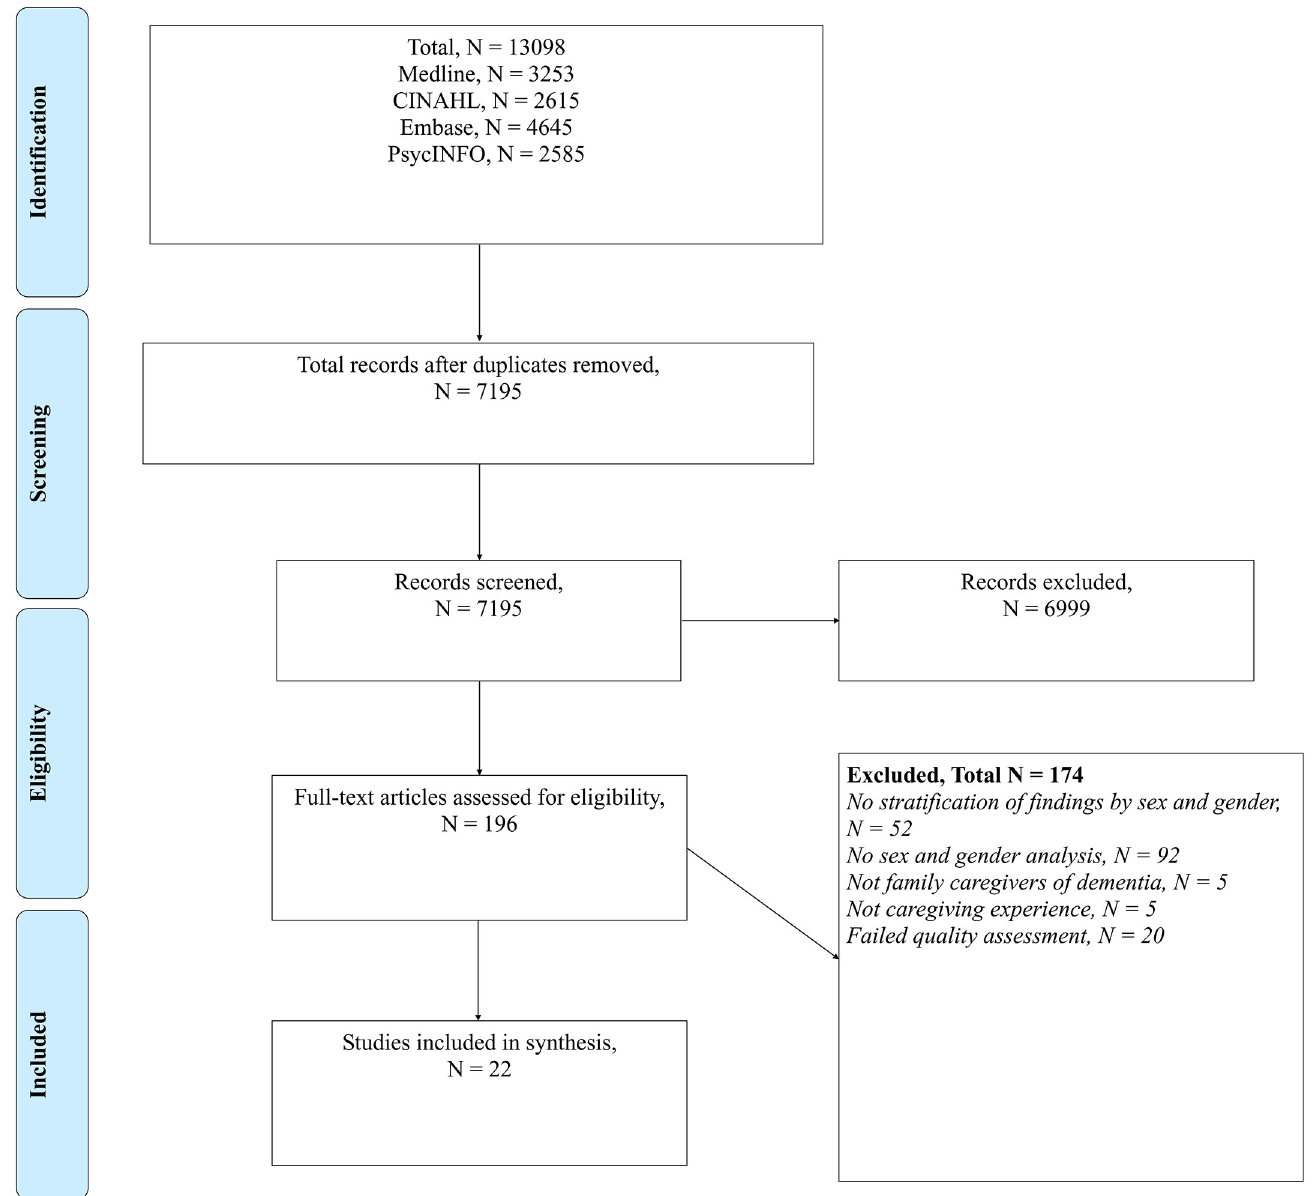
Fig 1. PRISMA diagram.